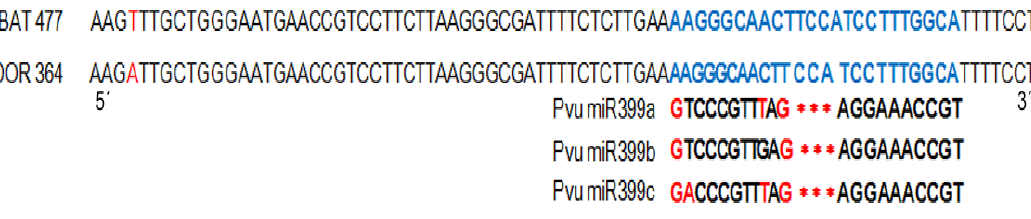
Figure 3. Alignment of all miR399 isoforms with the complementarity sequence of Pv4 gene (blue) from BAT477 and DOR364 genotypes. Nucleotides displaying full base pairing are shown in black, and those displaying a mismatch are shown in